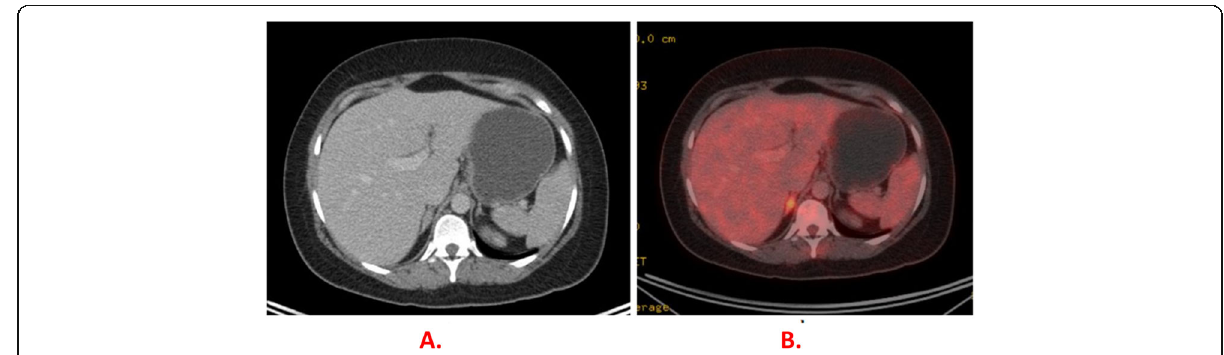
Fig. 3 A 37-year-old female patient, pathologically proven having NSCLC; the initial staging showed a CECT revealed normal radiographic features of right adrenal gland and the patient was staged as M0 and III B, and b PET/CT showed high FDG uptake in the right adrenal gland (SUV = 10) indicating adrenal metastasis and the patient was upstaged from M0 to M1b and from IIIB stage to